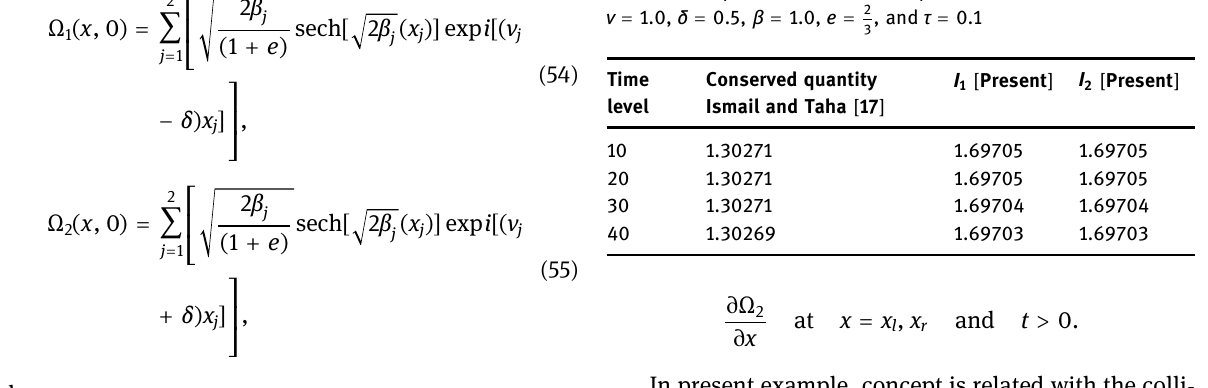
Table 3: Comparison of conserved quantities, = N 501